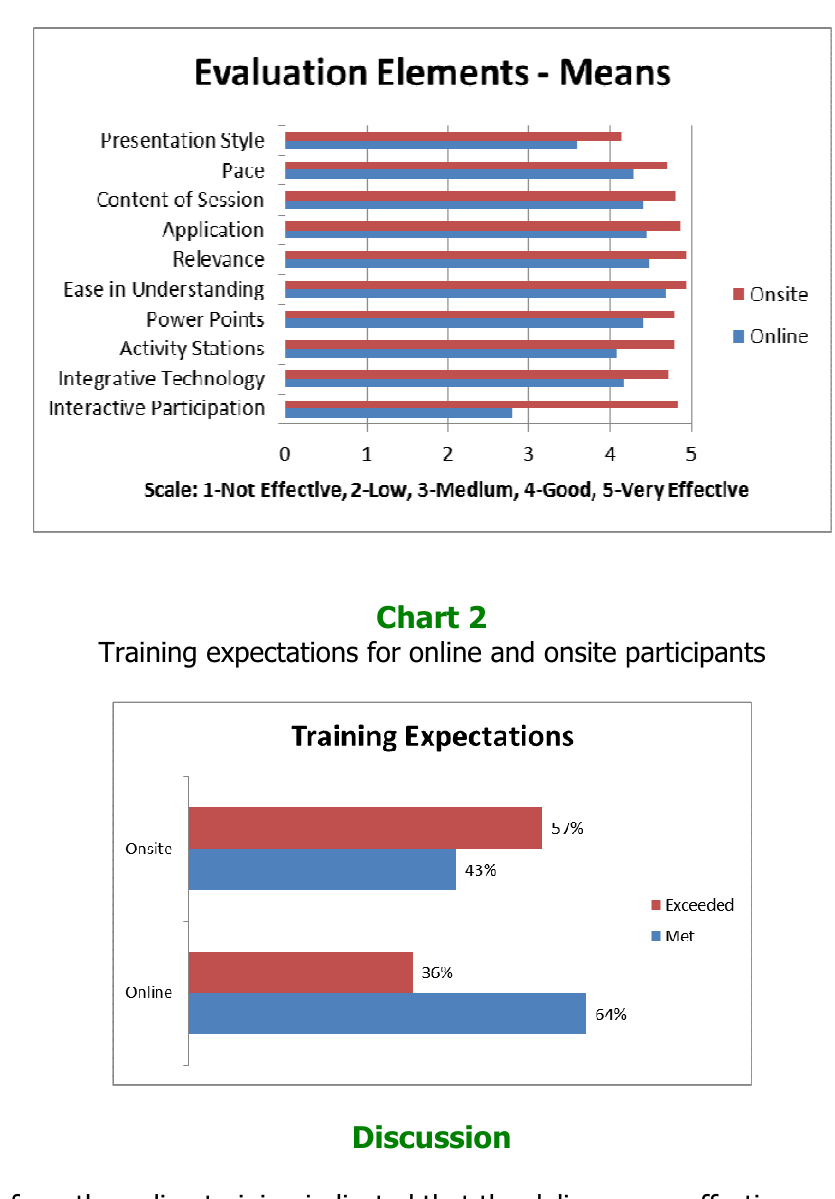
Adult participant opinions on information and delivery based on Likert rating